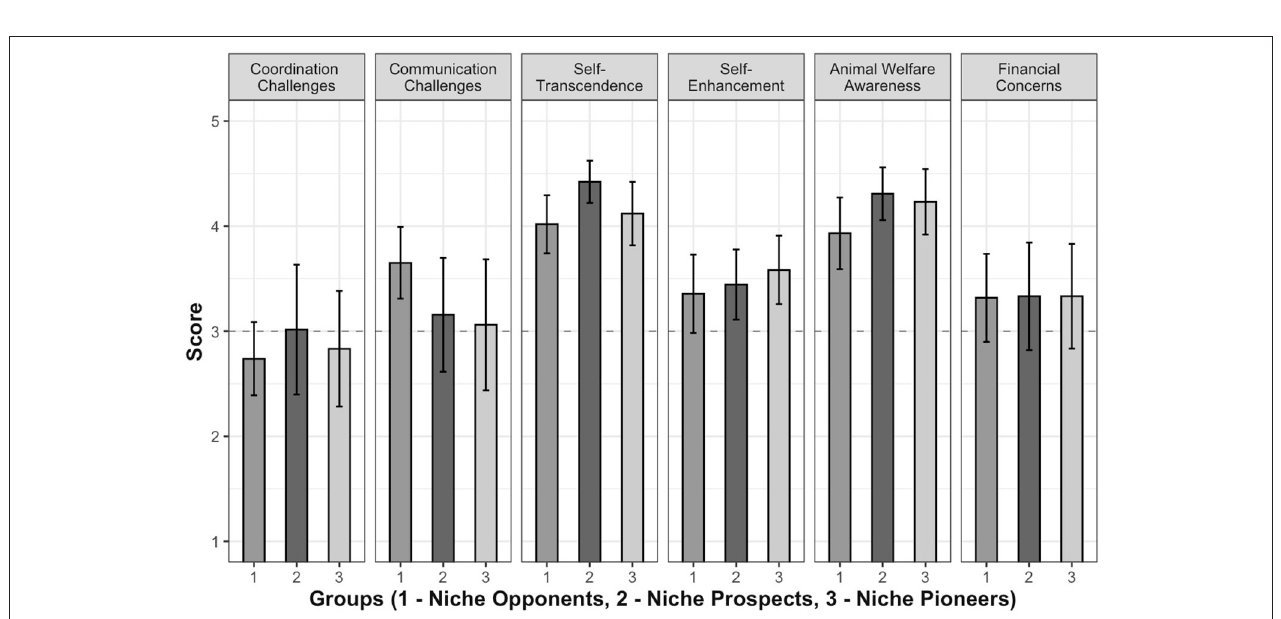
FIGURE 1 | Past and future product-range decisions regarding grass-fed beef. 1 Based on the question “Does your product range currently include grass-fed beef?” (1 = “no, I cannot imagine including it in the future”; 2 = “no, but I am considering introducing it”; 3 = “no, but I have tried it in the past”; 4 = “yes, with moderate success”; 5 = “yes, with considerable success”). 2 Based on the question “How probable is it that you will stock (or continue to stock) grass-fed beef in 2020?” (1 = “very unlikely”; 2 = “improbable”; 3 = “undecided”; 4 = “probable”; 5 = “very probable”).